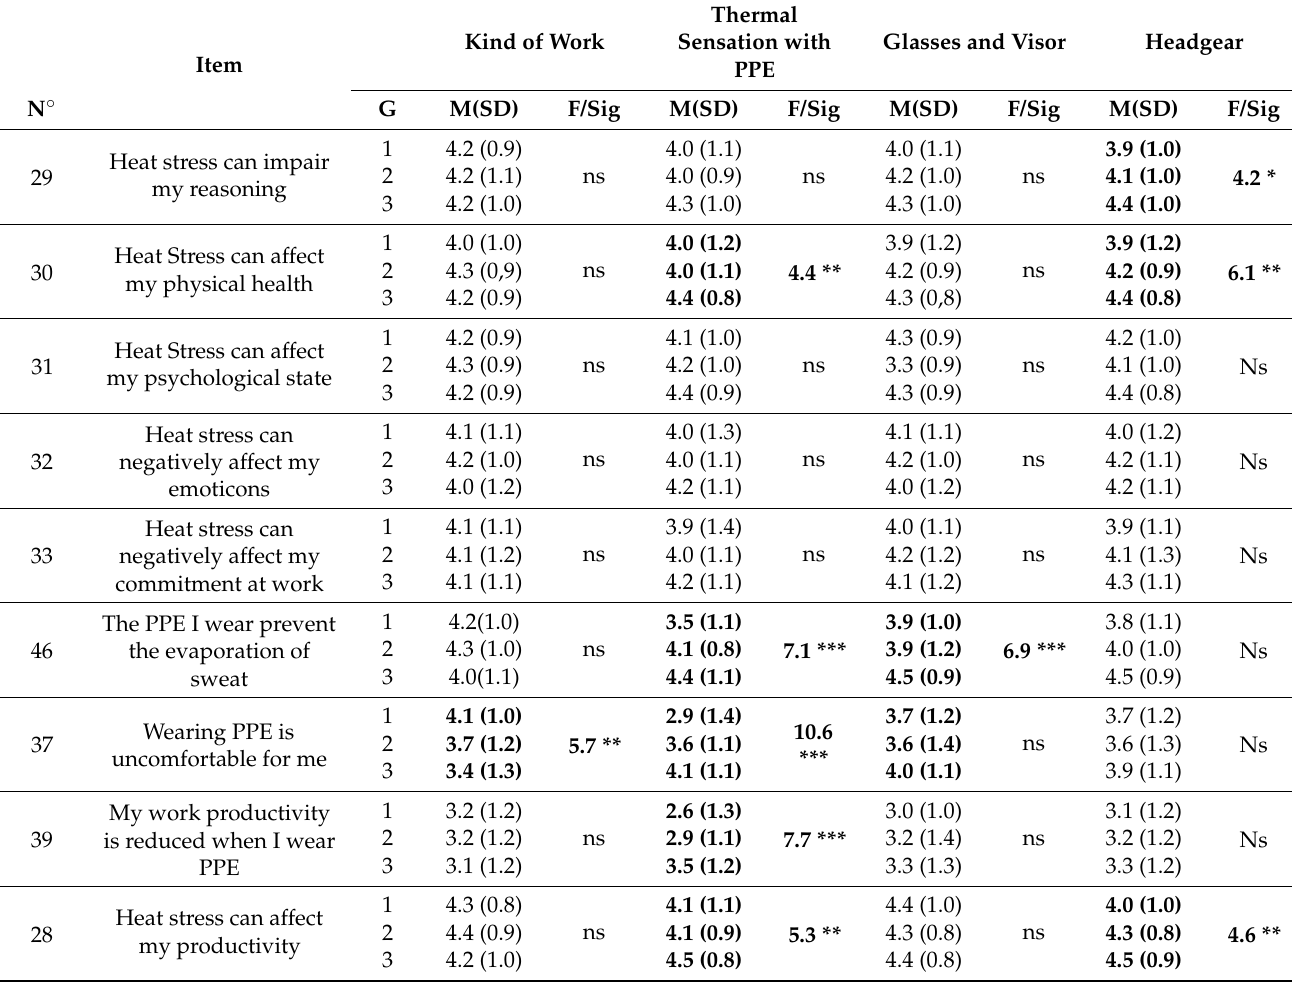
Table 3. Difference between groups concerning issues related to the effects of the heat stress on workers and their productivity loss